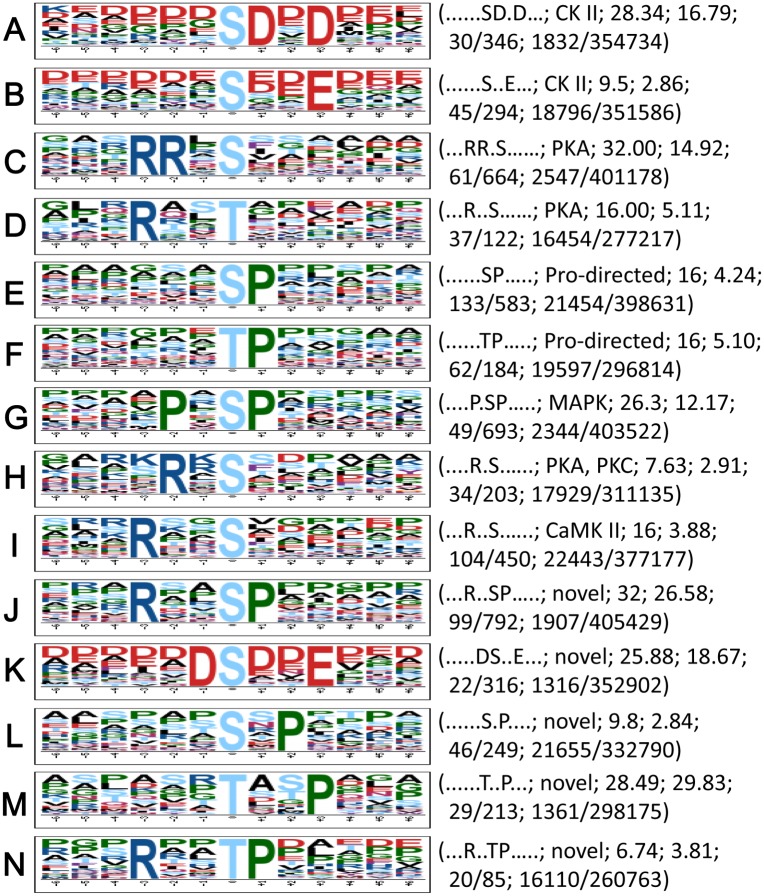
Phosphorylation motifs found in the B. bassiana Cdc14-specific phosphoproteome with Motif-x.All logos were created using WebLogo (http://weblogo.berkeley.edu). The height of each amino acid indicates the level of conservation at that position. Listed in parentheses are the sequence of each motif, potential kinase, score, fold increase, the foreground counts of matches (Fmatch) and identified phosphopeptides (Fsize), and the background counts of matches (Bmatch) and all the identified peptides (Bsize) in the software database, respectively. Fold increase = (Fsize/Fmatch)/(Bsize/Bmatch).